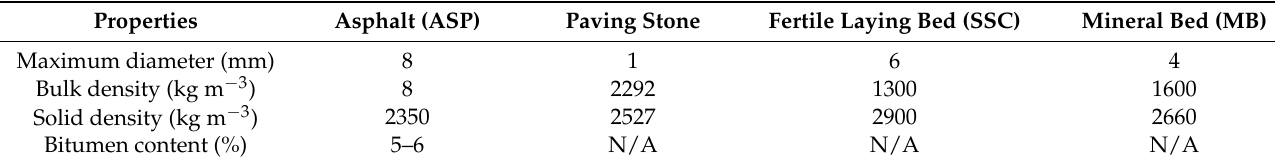
Table 3. Physical properties of